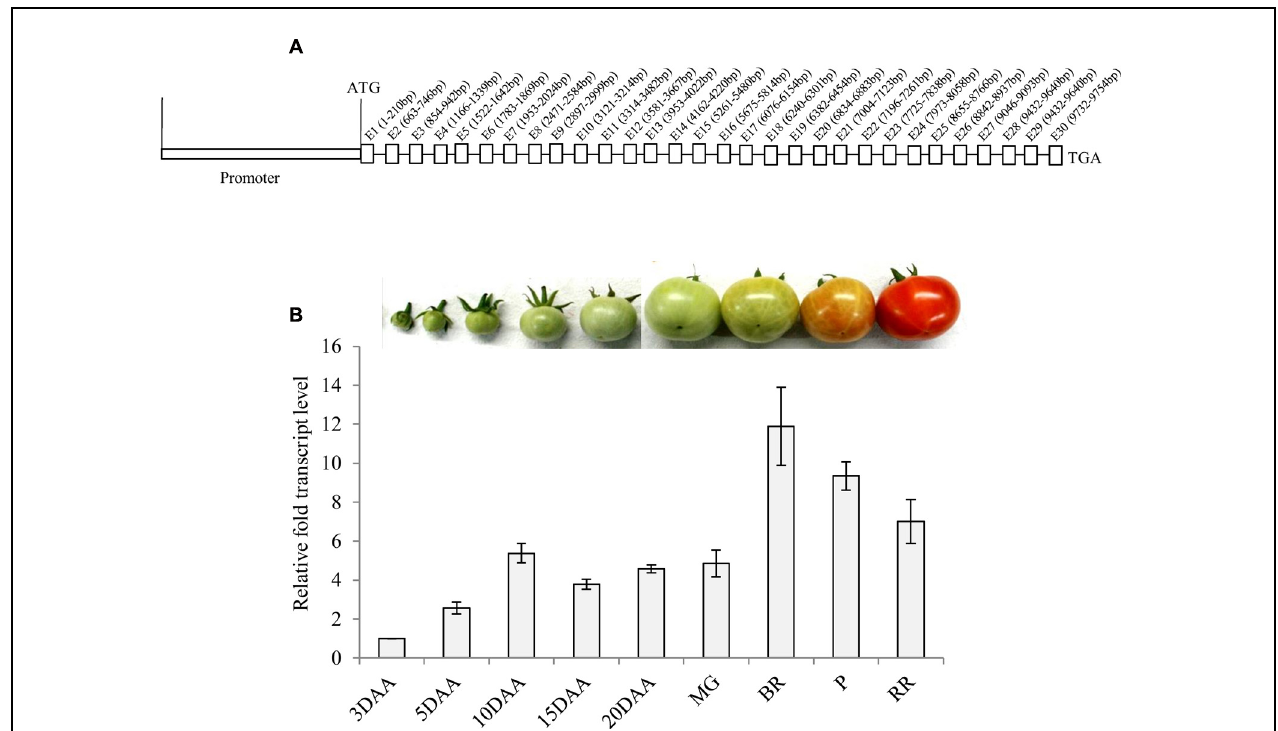
FIGURE 1 | α -Man genomic organization and transcript abundance pattern during tomato fruit development and ripening. (A) Genomic organization of α -Man . Introns on α -Man gene were identified following intron finder tool (solgenomics.net). (B) Expression analysis of α -Man during fruit development and ripening. RNA was isolated from fruits of various developmental stages (3DAA–20DAA) and ripening stages (MG, BR, P and RR). The transcript level of α -Man was determined by qRT-PCR analysis. Tomato actin was used as endogenous control. Data are mean ( ± SE) of three biological replicates.